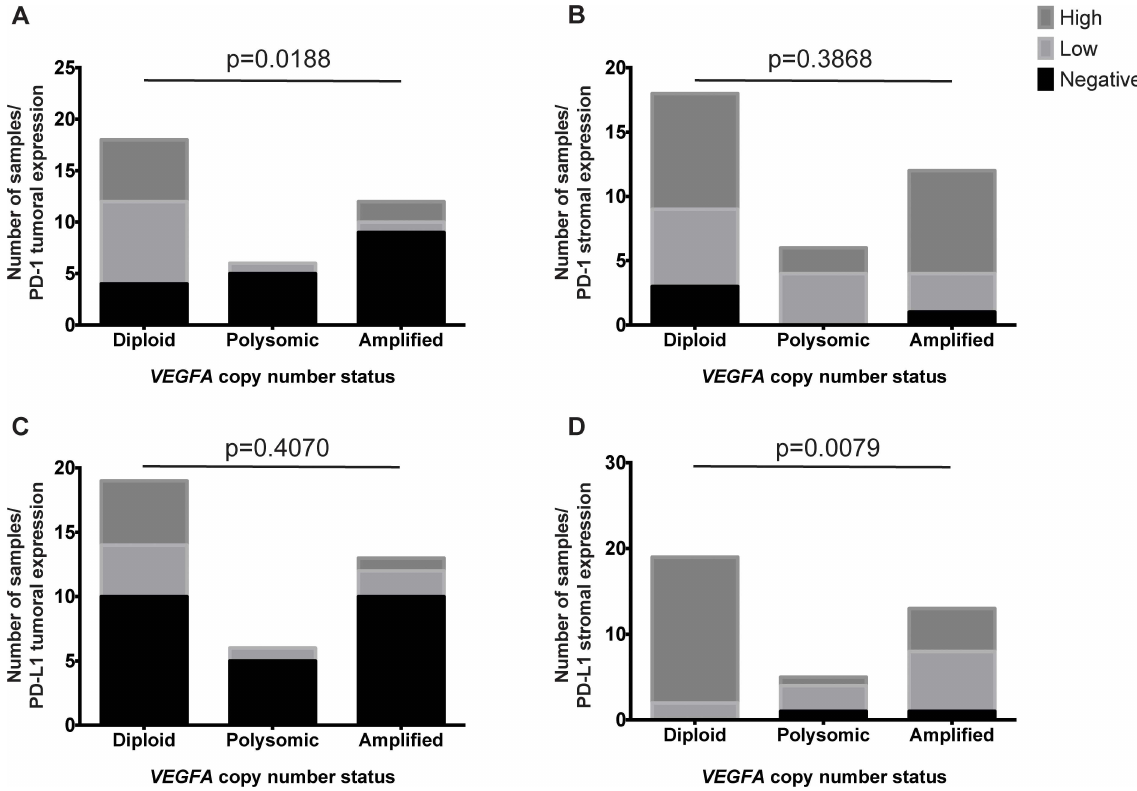
Fig 4. PD-1-positive tumor infiltrating and stromal lymphocytes and PD-L1 tumoral and stromal expression in colorectal cancers. Barplots depict the numberof samples with high, low and negativeexpressionof (A, B) PD-1 and (C, D) PD-L1 in (A, C) tumoral and (B, D) stromal areas of